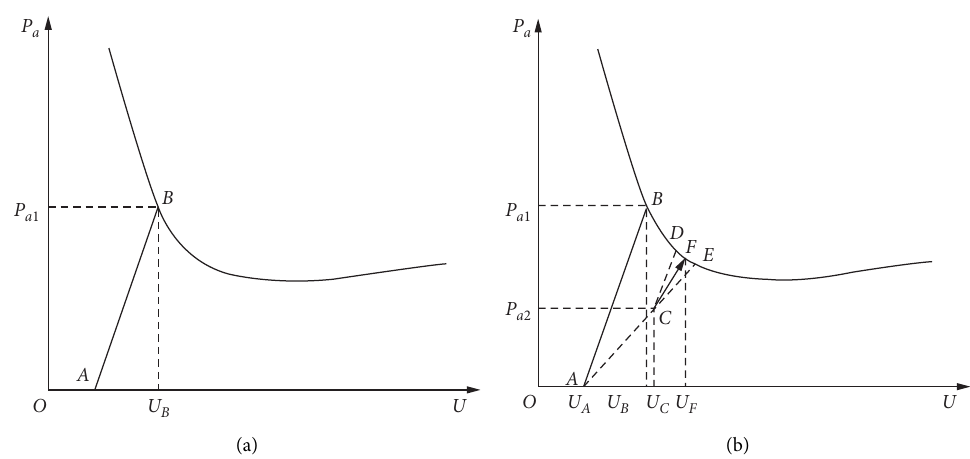
Figure 2: Support characteristic curve. (a) Single primary support structure. (b) Double primary support